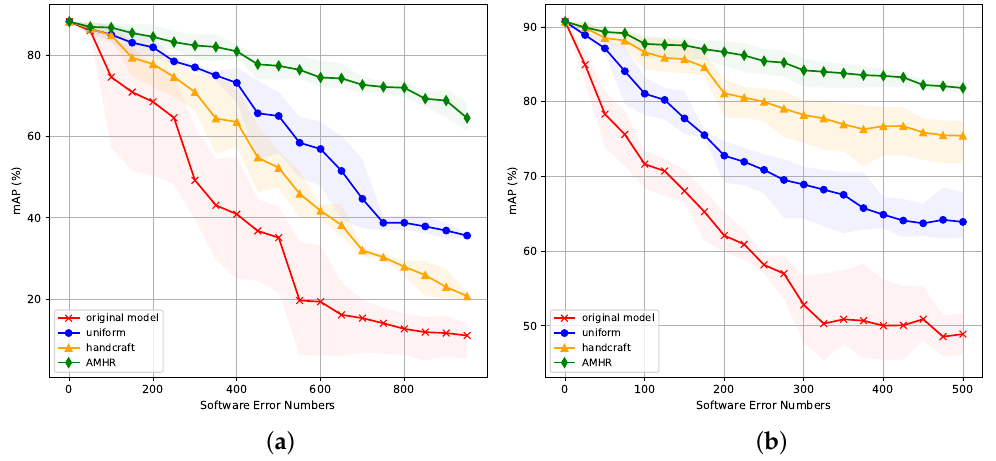
Figure 11. Performance losses of hardening detectors with multiple errors: ( a ) shows the mAP drops with increased feature map errors for hardened SSD detectors; ( b ) shows the mAP drops with increased feature map errors for hardened Faster R-CNN